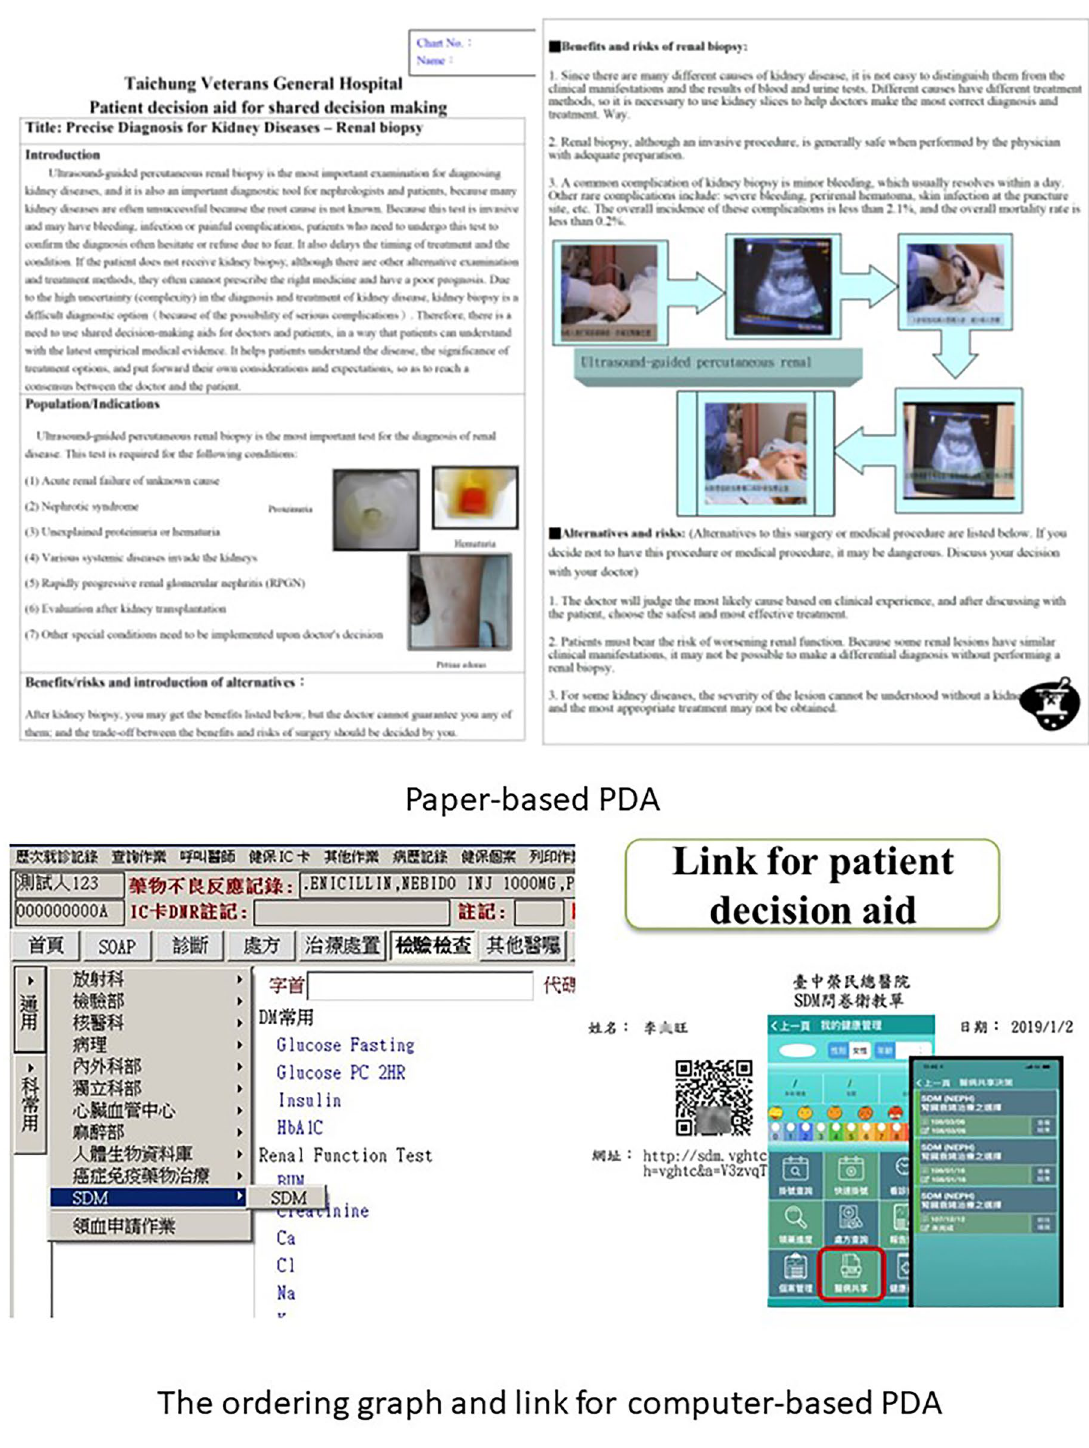
Figure 1. The representative graph for paper-based PDA and the link for computer-based PDA (Should I receive renal biopsy in order to obtain precise diagnosis? Yes, or